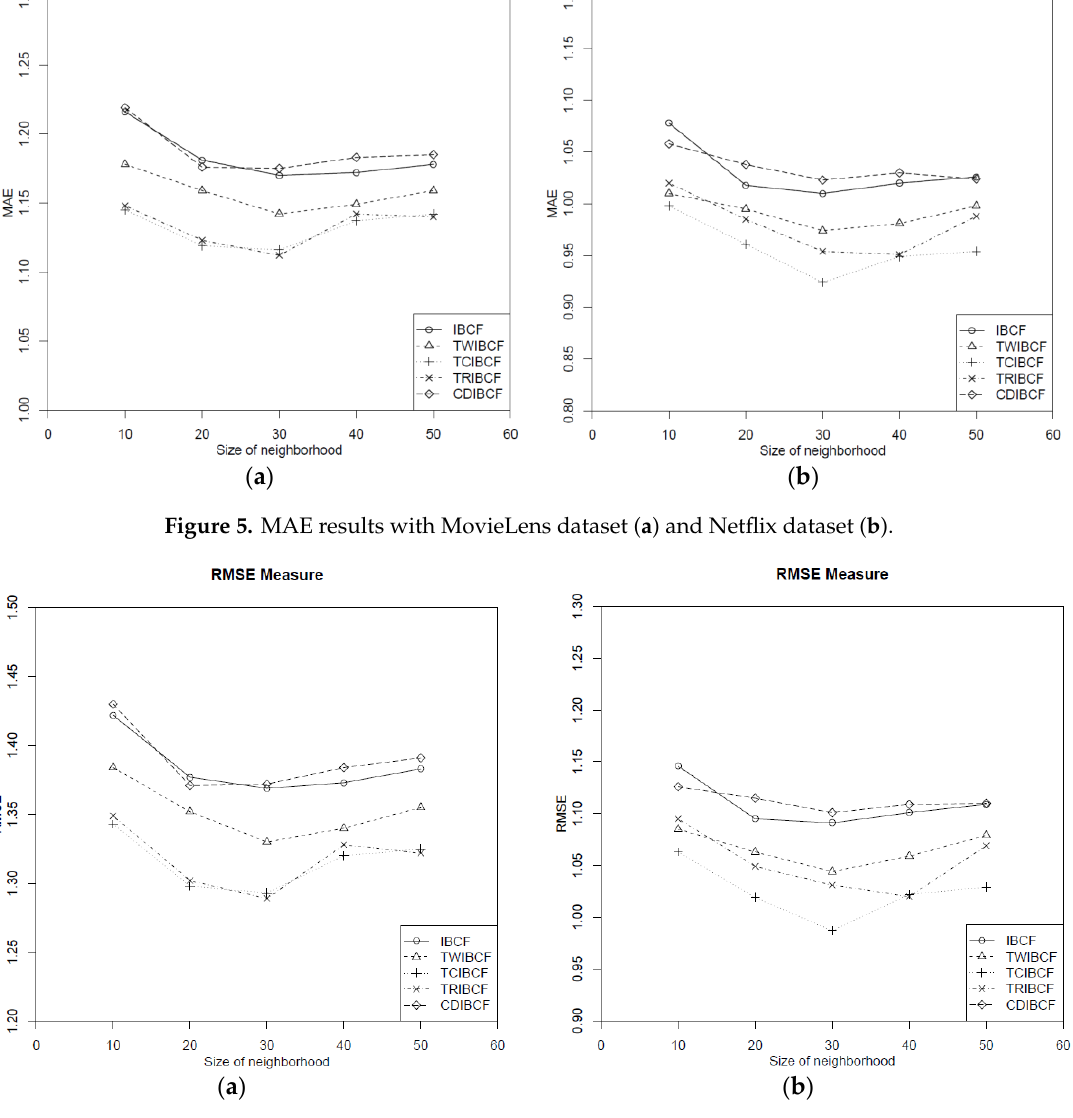
Figure 6. RMSE results with MovieLens dataset ( a ) and Netflix dataset ( b ).